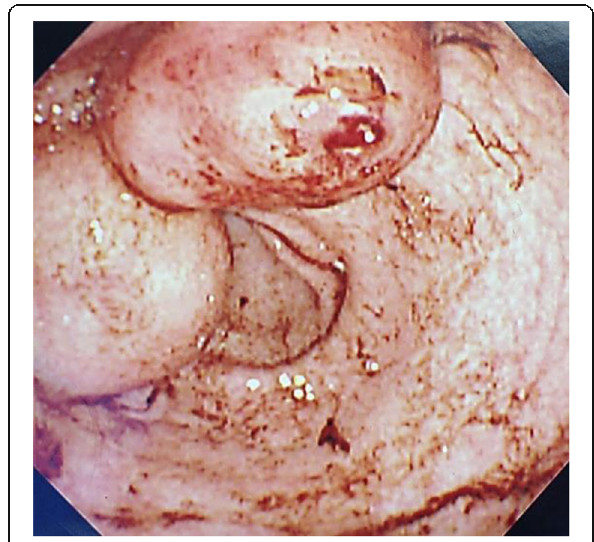
Fig. 1 Endoscopic examination of the upper gastrointestinal tract showing the presence of two submucosal tumors in the pyloric antrum